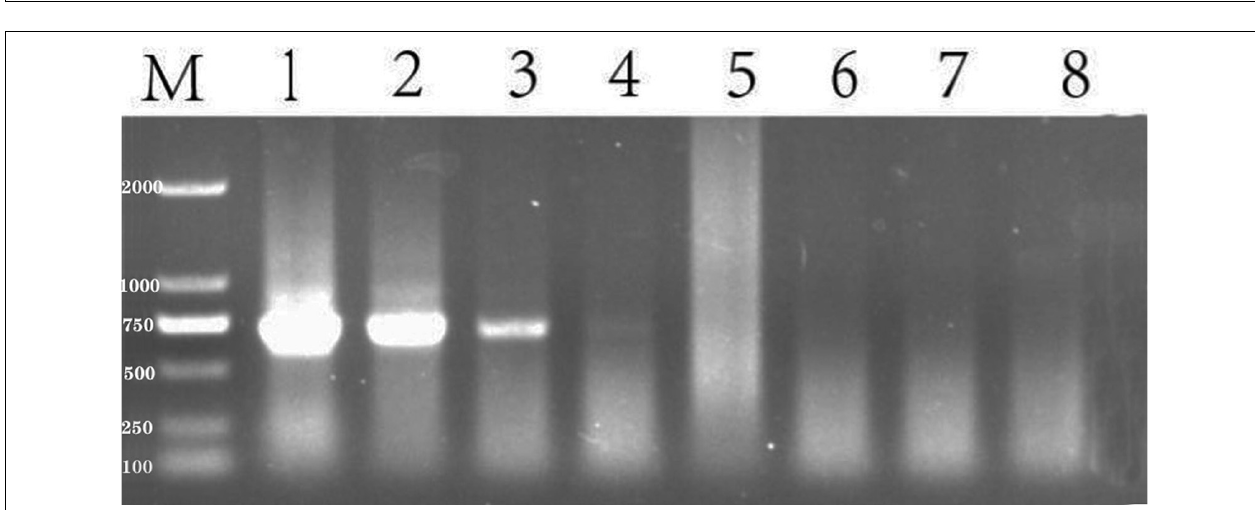
FIGURE 3 | PCR products amplified from genomic DNA of S. reilianum using YGSP (lane 1–5) and SR3 (lane 6–10) primer pairs, subsequently separated on a 1% agarose gel. Lane M is DNA ladder DL2000.